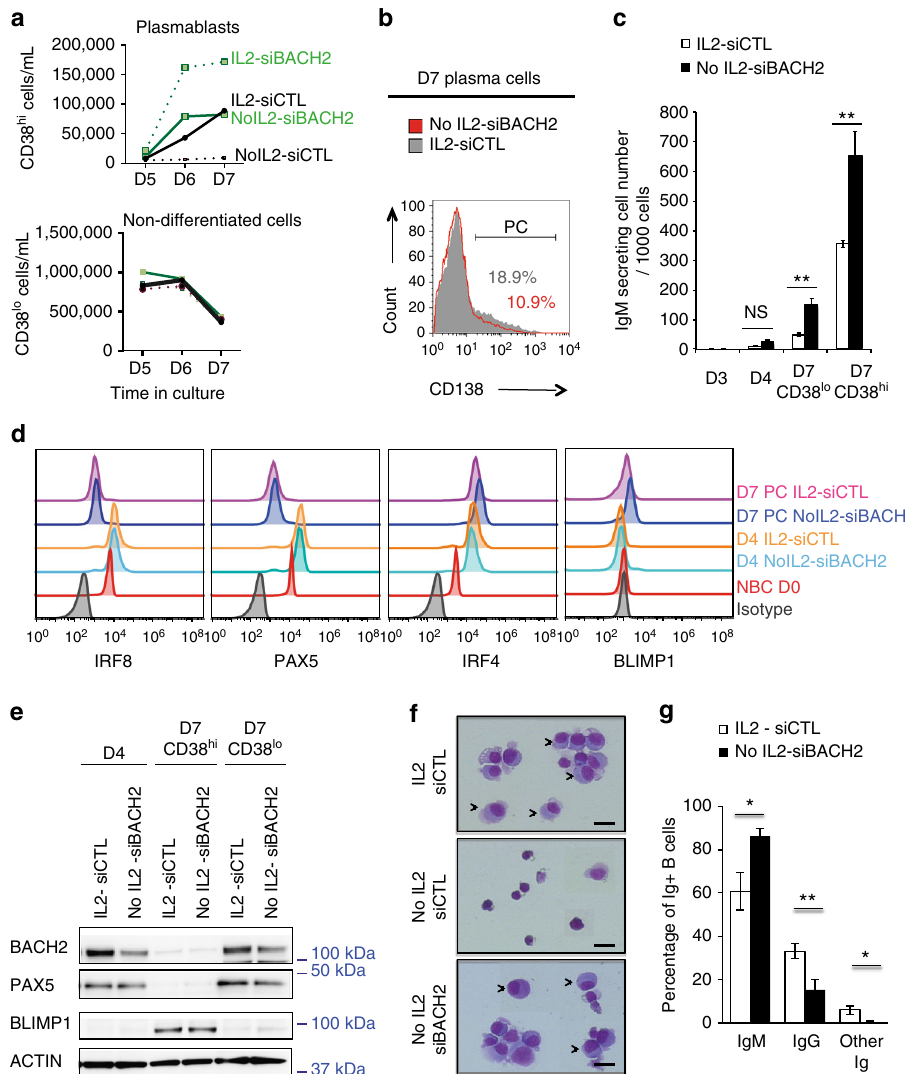
Fig. 3 Differentiated B cells driven by siBACH2 exhibit a plasma cell identity. a Differentiation kinetics from D5 to D7 analysed by fl ow cytometry by the quanti fi cation of absolute cell number of plasmablasts CD38 hi (upper panel) and CD38 low (lower panel) generated from naive B cells that were electroporated with siBACH2 (green lines) or siCTL (black lines), primed or not with IL-2 (solid and dashed lines, respectively). A representative experiment from three independent experiments is shown. b Expression of the plasma cell marker CD138 analysed by fl ow cytometry at D7 within the differentiated CD38 hi compartment that were IL-2 primed (IL2-siCTL) or generated with BACH2 inhibition (No IL2-siBACH2). A representative experiment from four independent experiments is shown. c IgM secretion measured by ELISPOT at the indicated days and in sorted populations based on CD38 expression level at D7. A representative experiments from two independent experiments is shown. d Flowplots of B cell factors (IRF8, PAX5) and plasma cell transcription factors (IRF4, BLIMP1) expression by naive B cells (D0), D4-activated B cells and D7 sorted plasmablasts (PC, based on CD38 hi expression). Cells were primed with IL-2 when speci fi ed and electroporated at D2 with siBACH2 or the control siRNA. Corresponding isotypes were used as negative staining control. e Western blot analysis of BACH2, PAX5 and BLIMP1 expression by D4 and D7 sorted plasmablasts (CD38 hi ) and non-differentiated cells (CD38 lo ) that were primed or not with IL-2 and electroporated at D2 with siBACH2 or the control siRNA. f Cytospin and Giemsa staining of plasmablasts generated from BACH2 de fi cient naive B cells (No IL2-siBACH2) compared to controls. Representative cells are shown (×630 objective, scale bar 20 μ m). They displayed features of plasmablasts (arrows), the nucleus is eccentric comparable to plasmablasts generated from naive B cells primed with IL-2 (IL2-siCTL). g Assessment of immunoglobulin class switching in CD38 hi cells at D7 generated from naive B cells de fi cient from BACH2 (No IL2-siBACH2) or cells that were primed with IL-2 (IL2-siCTL). Data are presented as percentage of positive cells for intracellular staining of IgM and IgG evaluated by fl ow cytometry. Means ± s.e.m. of four independent experiments. Signi fi cant differences are shown. For experiments shown in c and g * p < 0.05, ** p < 0.01, NS: non-signi fi cant differences, two-tailed unpaired Student ’ s t -test (Fig. 3c), and of B cell and plasma cell transcription factors We then studied the kinetic of the differentiation. Only few expression con fi rmed the kinetic of the differentiation (Fig. 3d, e). plasmablasts emerged from the No IL2-siBACH2 condition at D5 In coherence with the differentiation process triggered by IL-2 (Fig. 3a). The maximum rate was obtained at D6 and maintained priming, differentiated cells induced by siBACH2 displayed low at D7. At that time plasma cell stage was reached for a small levels of PAX5 and IRF8 expression and high levels of BLIMP1 percentage of cells indicated by CD138 expression (9% ± 1.2; n = and IRF4 as compared to naive B cells. Moreover, differentiated 5, Fig. 3b). Time course of immunoglobulin M (IgM) secretion NATURE COMMUNICATIONS | 8: